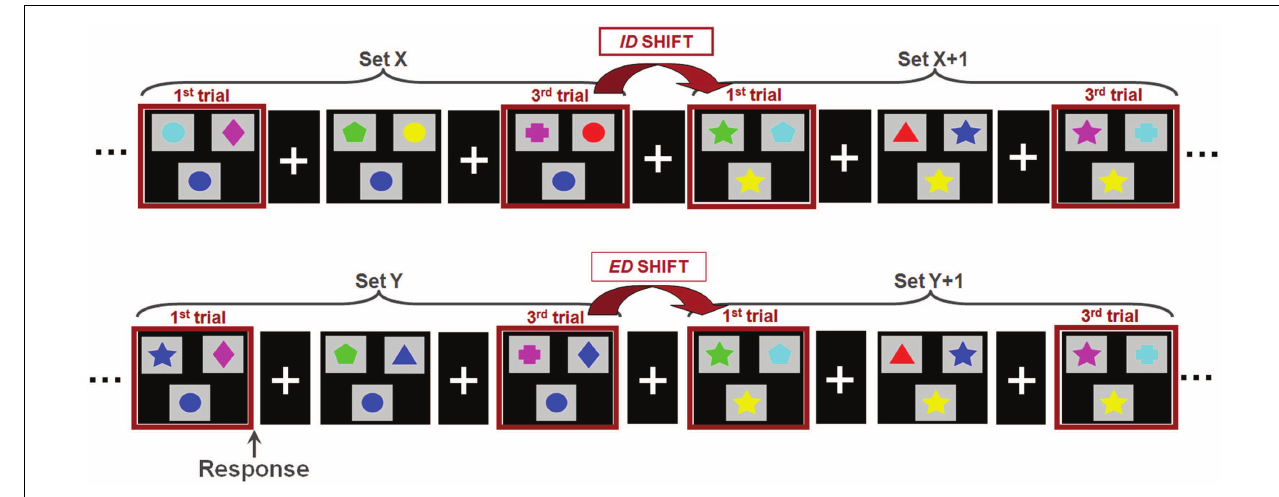
Between sets, the rule for matching changed. In an intradimensional shifts (ID; top), the rule for matching switched within a dimension (i.e., within color; green to red) whereas in extradimensional shifts (ED; bottom) the rule for matching switched between dimensions (i.e., color to shape; green to